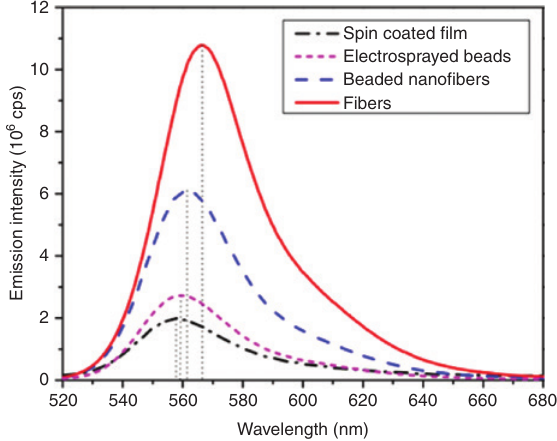
Figure 7: Emission intensity of thin-film and electrospun structures illuminated with a 450-W xenon lamp with monochromation for wavelength selection in excitation and emission. (Reprinted from Enculescu et al. J. Phys. Chem. Solids 75, 1365, © 2014 with permis- sion from